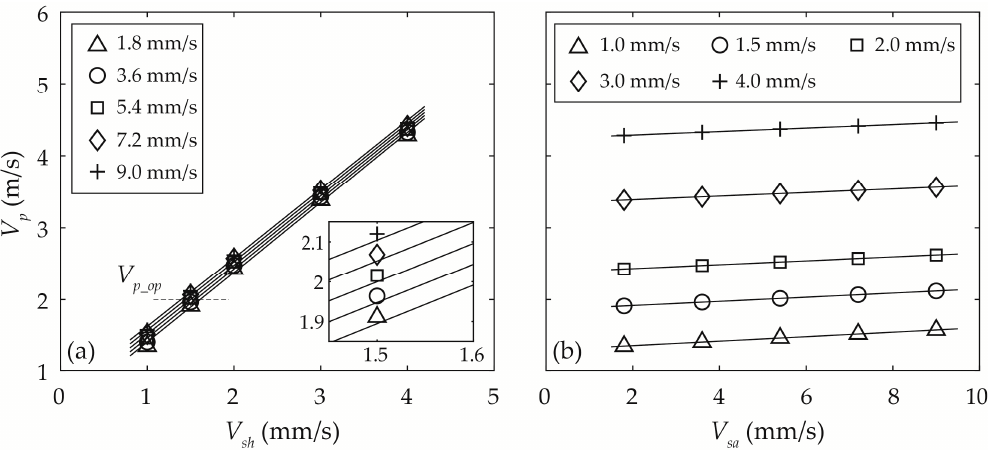
Figure 5. Sample particle velocity V p as a function of ( a ) sheath flow velocity V sh at five di ff erent sample flow velocities V sa , and ( b ) V sa at five di ff erent V sh . The dashed line in ( a ) represents the critical particle velocity V p _ op (i.e., 2 m / s). Table 4. The fitted coe ffi cients of sample particle velocity V p versus sheath flow velocity V sh at five di ff erent sample flow velocities V sa .